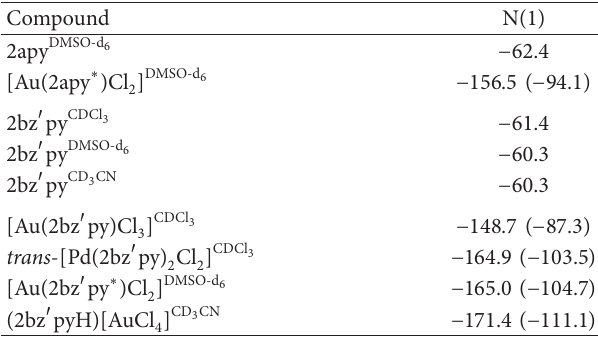
T 3: 15 N chemical and coordination/protonation shis (in parentheses) for Au(III) and Pd(II) chloride complexes, organometallics, and salts with 2apy or 2bz